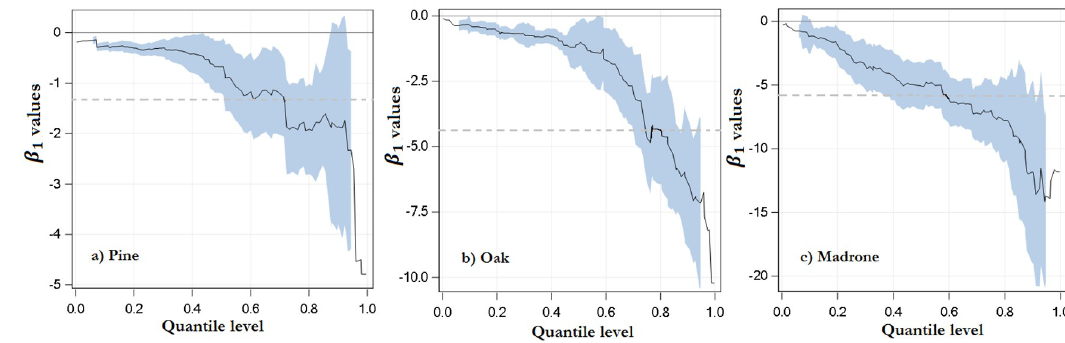
Fig 4. Quantile regression coefficients for the parameter DBH and 95% confidence limits as a function of quantile levels. The coefficients were adjusted to estimate the stemflow funneling ratio (Eq 3) for each genus. The dashed line in each figure represents the ordinary least squares estimate of the conditional mean